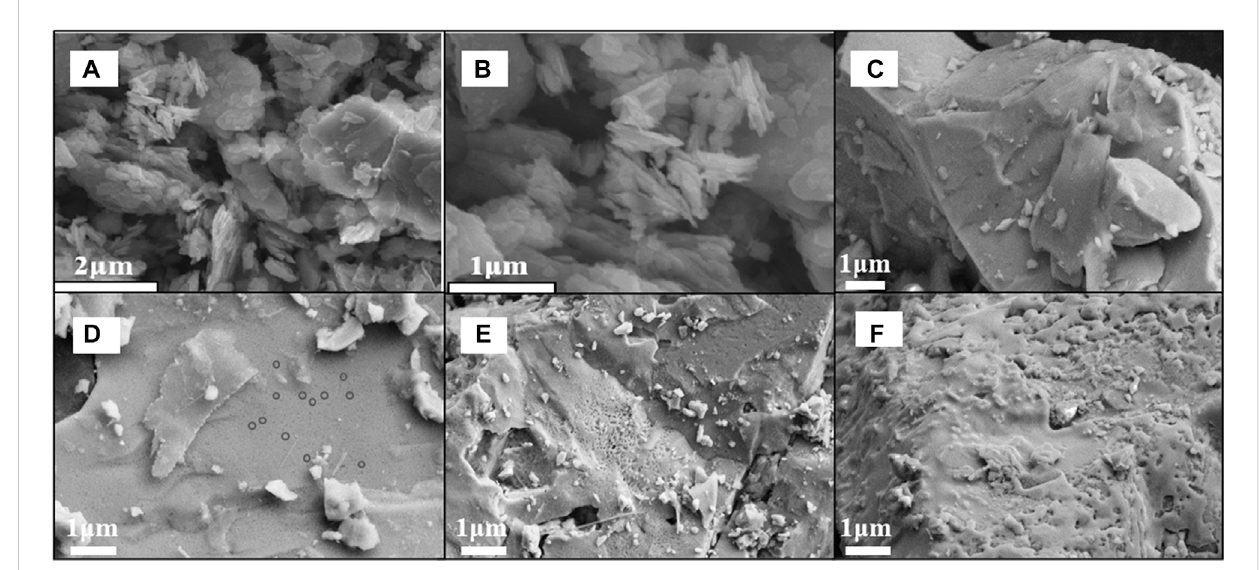
FIGURE 2 SEM images of magnetite (A, B) and its calcined products in argon at 300 ° C (C) , 500 ° C (D) , 700 ° C (E) , 900 ° C (F) .